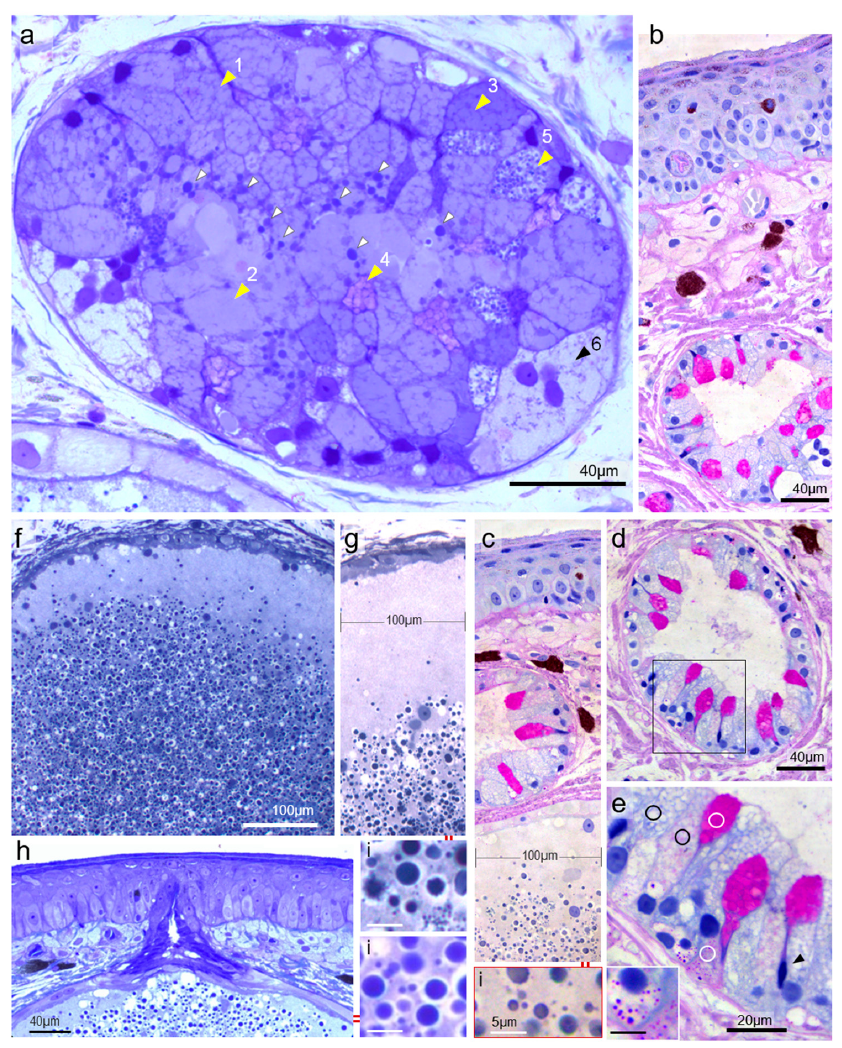
Figure 4. Large adenomeres contain all cell types and differentiation stages (see text) (1 µ m section, TolBlue) ( a ). Only a subset of mucous cells ( b ) are glucoprotein PAS+ secreting cells, whereas adjacent ones are PAS- ( c ) (2 µ m sections). All PAS+ cells are caliciform-type cells ( d ) interspersed between other cell types ( e ), storing secretion in their apical pole, and immature basal cells with PAS+ secretory granules (inset). Low power ( f ) serous (venom glands), (2 µ m section, iron haematoxylin) with a peripheral syncytium layer devoid of granules ( g ). Keratinised lumens of the secretory ducts ( h ) maintain a closed compartment under pressure. Granule staining showing similar aspects ( i ) and size distributions with iron haematoxylin, PAS, and toluidine blue methods, revealing their predominant protein nature (in sections) (photos by J.M. L ó